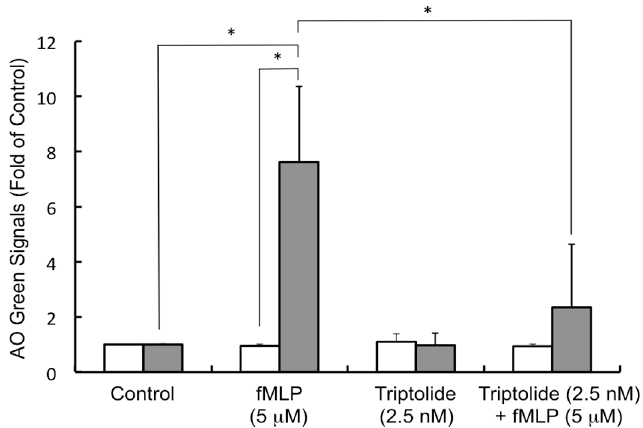
Figure 5. Triptolide suppressed the fMLP-mediated AO release in KU-812 cells. AO-loaded KU-812 cells were prepared for assay as described in Figure 2. Cells were then challenged with medium buffer alone (Control), fMLP (5 µM) or triptolide (2.5 nM) for AO release at room temperature (open bar) or 37 °C (solid bar) in the LOAD. In the last experiment, cells were pretreated with triptolide (2.5 nM) overnight at 37 °C, 5% CO 2 . After washing, the AO-loaded KU-812 cells were challenged with fMLP (5 µM) in the LOAD at room temperature or 37 °C. Signals from test groups are normalized with the control data. Results are mean ± SD ( n = 4), * p < 0.05.